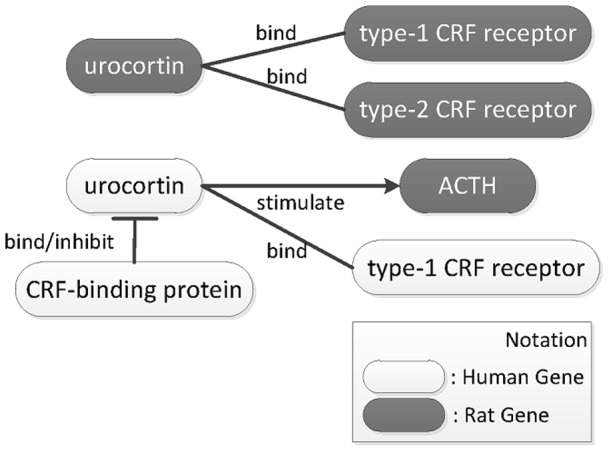
The pathway described in Figure 1.